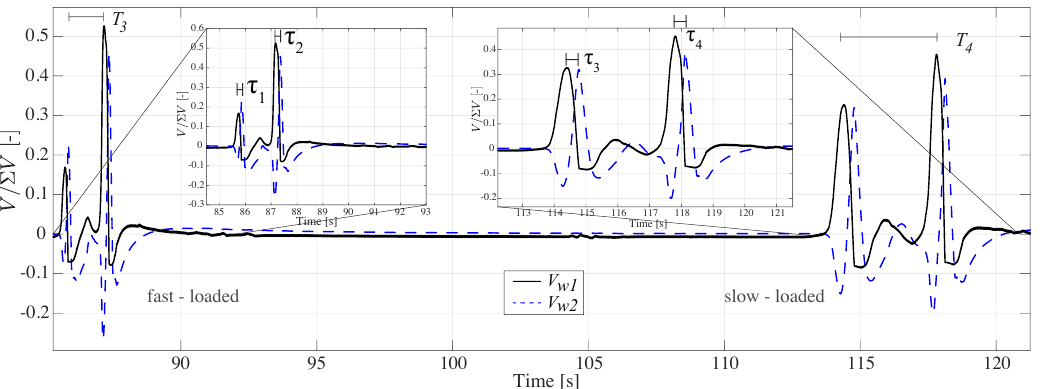
Figure 9. Relative time histories of V w 1 and V w 2 showing time shifts between peaks of the signals. Data shown plotted in Figure 9 can be used to calculate the axle spacing ( l ax ) of the bicycle. The distance between the midpoints of each half is taken as the reference length for spatial measurement, that is 12 cm ( δ ). The ratio of time shifts T from Figure 8 and average τ ( ¯ τ ) from Figure 9 is defined as the geometry constant ( γ ). The average τ ( ¯ τ ) is